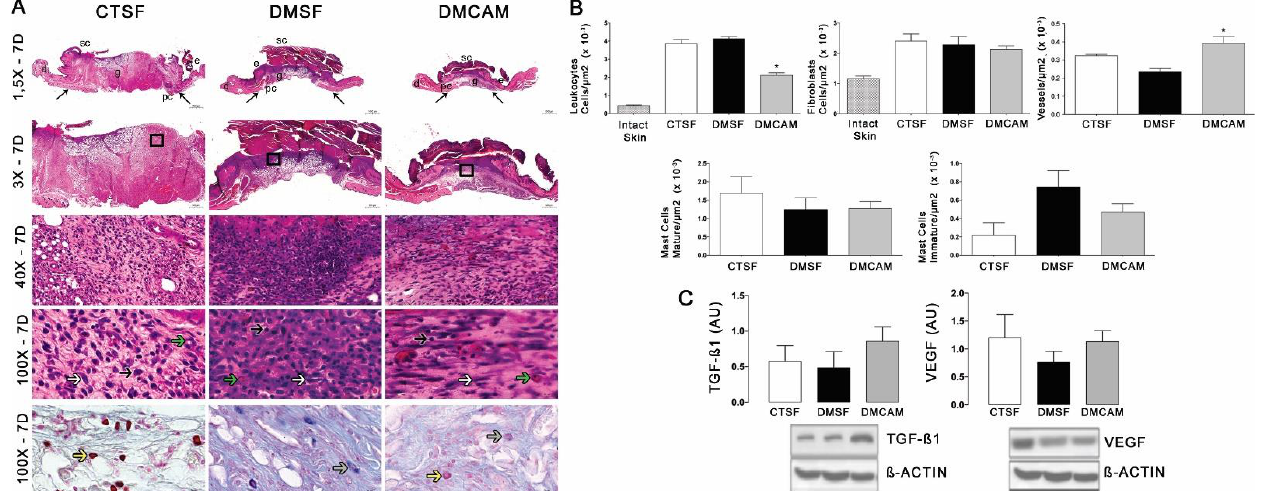
Figure 4. Topical treatment with plasticized chitosan-alginate membranes in diabetic mice reduced the number of inflammatory cells and fibroblasts and increased the density of new vessels in the wound bed. ( A ) photos representing skin stained with H&E on day 7 of the wound. Less enhanced black arrows indicate the location where the excisional wound was performed. Small letters represent: sc, scab; e, epidermis; g, granulation tissue; d, dermis; pc, panniculus carnosus. Boxes in the upper panels indicate areas where regions that were amplified are shown to illustrate leukocytes (black arrows), fibroblasts (white arrows), and new vessels (green arrows). ( B ) number of leukocytes, fibroblasts, vessels, and blood capillaries by μm 2 × 10 − 3 ; at day 7, the DMCAM group showed a significantly lower number of leukocytes in comparison to the CTSF and DMSF; a number of blood vessels significantly higher was observer in the DMCAM group in comparison than to those in the CTSF and DMSF groups. Histological stain with Alcian-Blue + Safranin on skin fragments on day 7 after creating the wound on the backs of mice for analysis of mature mastocytes (yellow arrows) and immature mastocytes (grey arrows). ( C ) Analysis of the skin fragment (wound) with Western Blotting, with VEGF and TGF −β1 and Beta Actin (Control), of animal groups CTSF, DMSF, and DMCAM, on post-wound day 7. * Groups statistically different ( p < 0.05), compared by One-way ANOVA, followed by a Tukey multiple comparison test Enlargements of 1.5 × , 3 × , 40 × e 100 × ; scale bar = 1000 µ m, 500 µ m, 50 µ m and 20 µ